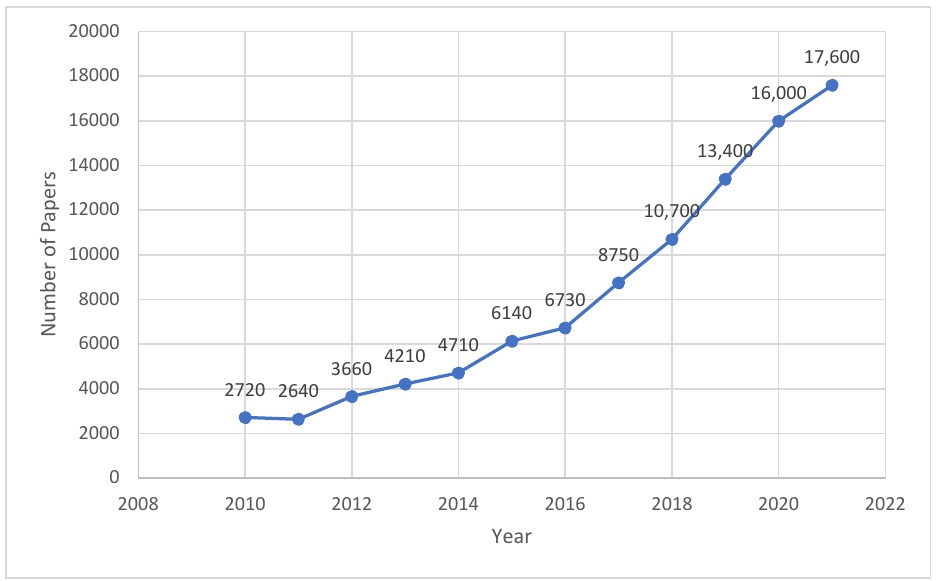
Figure 3. Papers about lithium-ion battery recycling—volume published per year. 4.3. The Recycling Process Figure 4 illustrates the lithium-ion battery recycling process.